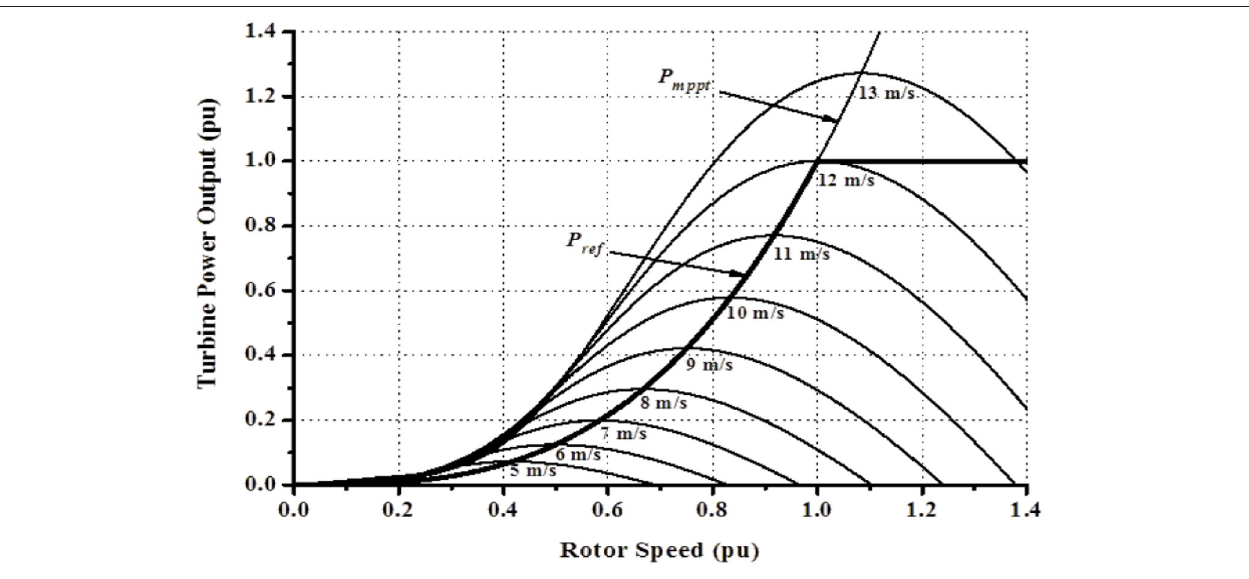
FIGURE 5 | The PMSG wind turbine maximum power characteristics.